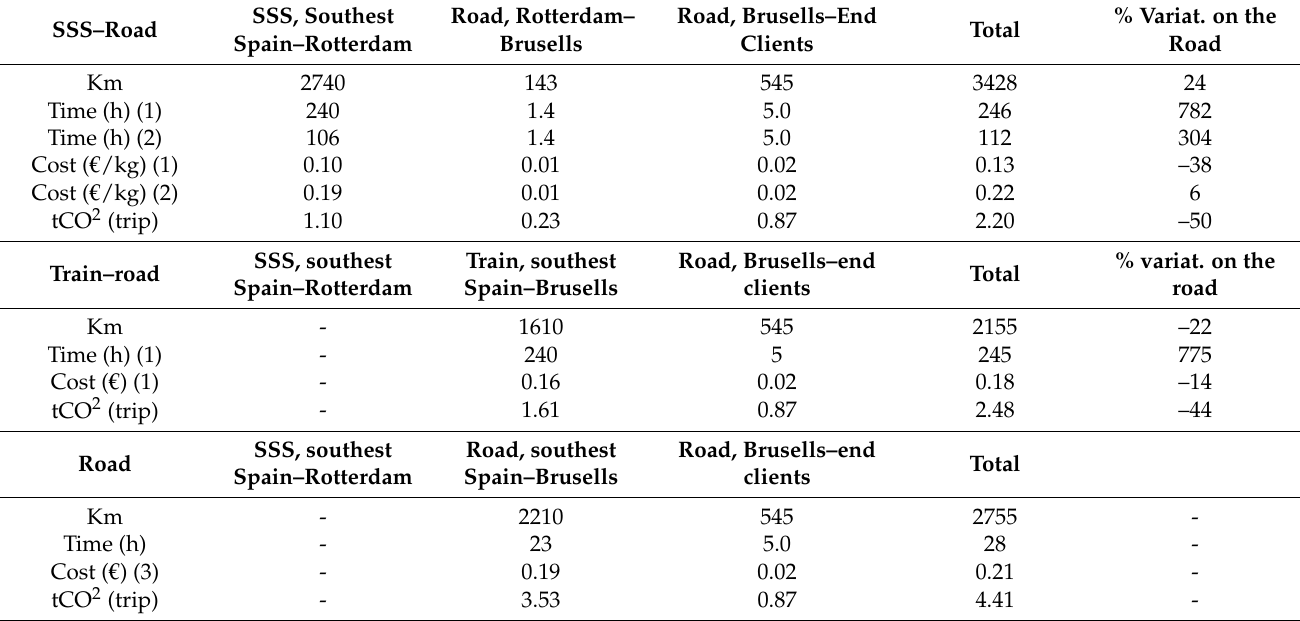
Table 2. Examples of the results for intermodal transport for P-C2 (Figure 5, map 1).